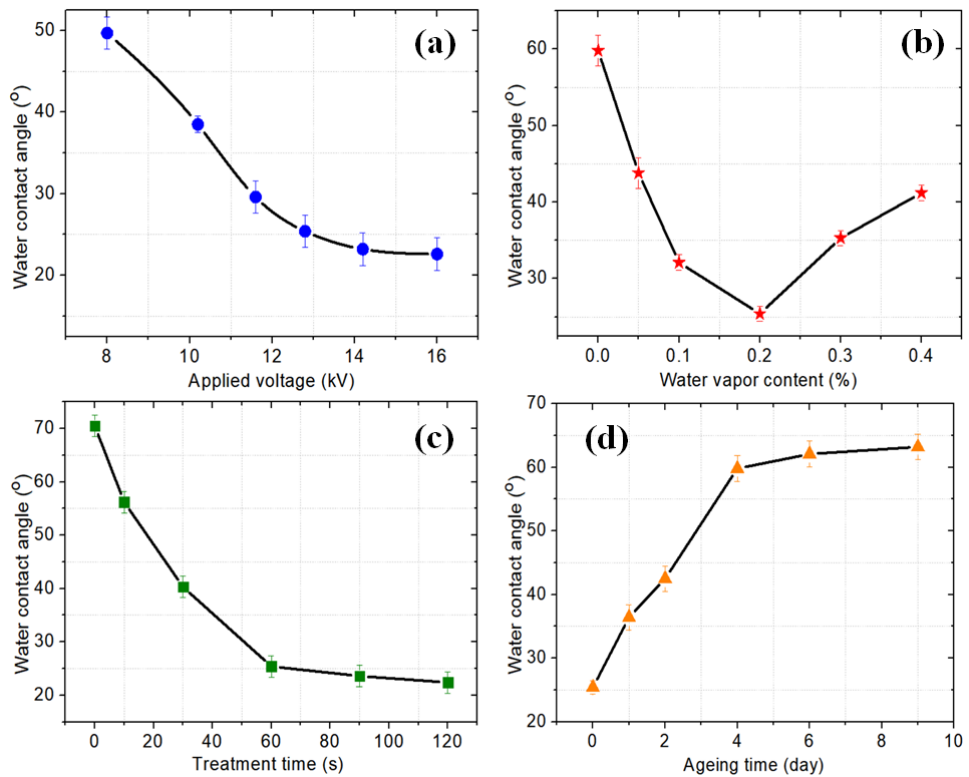
Figure 6. Water contact angles of plasma-modified PI films as a function of ( a ) applied voltage (water vapor content: 0.2%, plasma treatment time: 60 s), ( b ) water vapor content (applied voltage: 12.8 kV, plasma treatment time: 60 s), ( c ) plasma treatment time (applied voltage: 12.8 kV, water vapor content: 0.2%) and ( d ) aging time (applied voltage: 12.8 kV, water vapor content: 0.2%, plasma treatment time: 60 s).